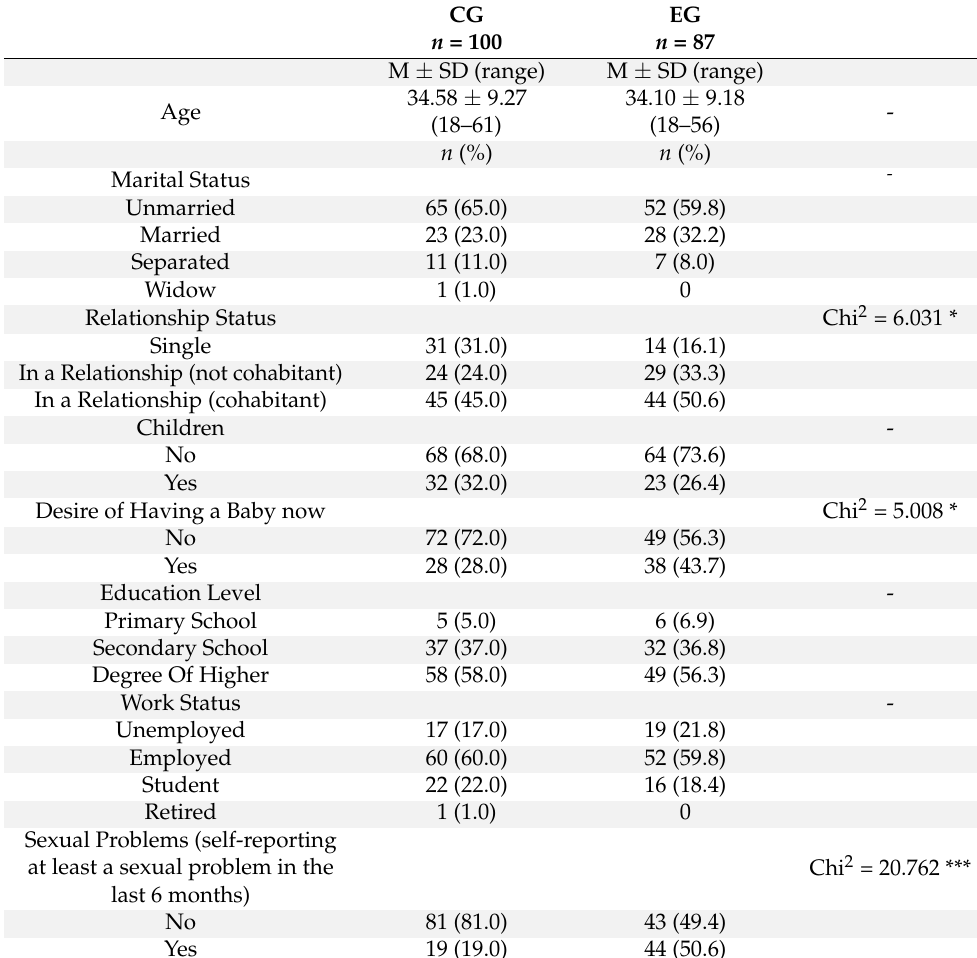
Table 1. Sociodemographic characteristics of the